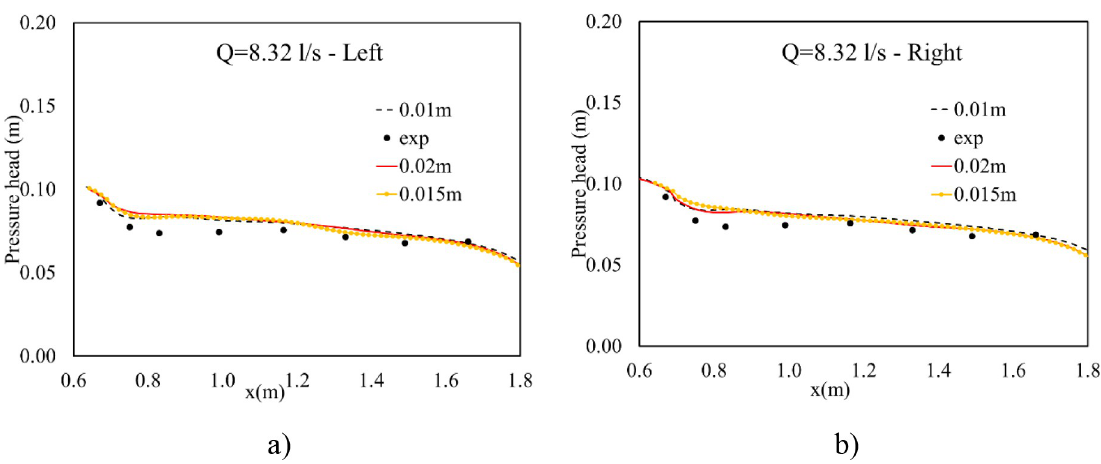
Fig 4. Pressure head distribution along the centerline of two tubes of Run 1. a) Left box tube; b) Right box tube. https://doi.org/10.1371/journal.pone.0275347.g004 3.1.2 Pressure head at the bottom of boxed tubes. By using a set of piezometer tubes connected with eight gauge points along the central line of each tube, potential pressure heads were collected. Accounting for run 1, good matching was observed near the exit of the culvert, while overestimation between them was indicated near the inlet in Fig 4. Conversely, the much better agreement between numerical and experimental results was verified, as seen in Fig 5, when Q = 16.14 L/s. The finest mesh of 0.01 m gave the best result at the entrance of the intake tube, while the largest misplacement at the exit of the culvert was seen at this cell size. The coarsest one provided the largest difference between simulated and observed results (Fig 5) and the largest values of NRMSE and MAE in both box tubes (Table 3). Moreover, the most suitable solution was provided using a resolution mesh of 0.015 m (Fig 5), and this cell size also gave the smallest values of NRMSE and MAE, indicating the most suitable grid size (Table 3). This is because the 0.015 m grid size performed better at the culvert bottom than the others; hence, it simulated more crucial pressure at the basement of the culvert. Therefore, this cell size was taken to simulate other hydraulic features and to characterize sediment scour mechanisms at the downstream channel.